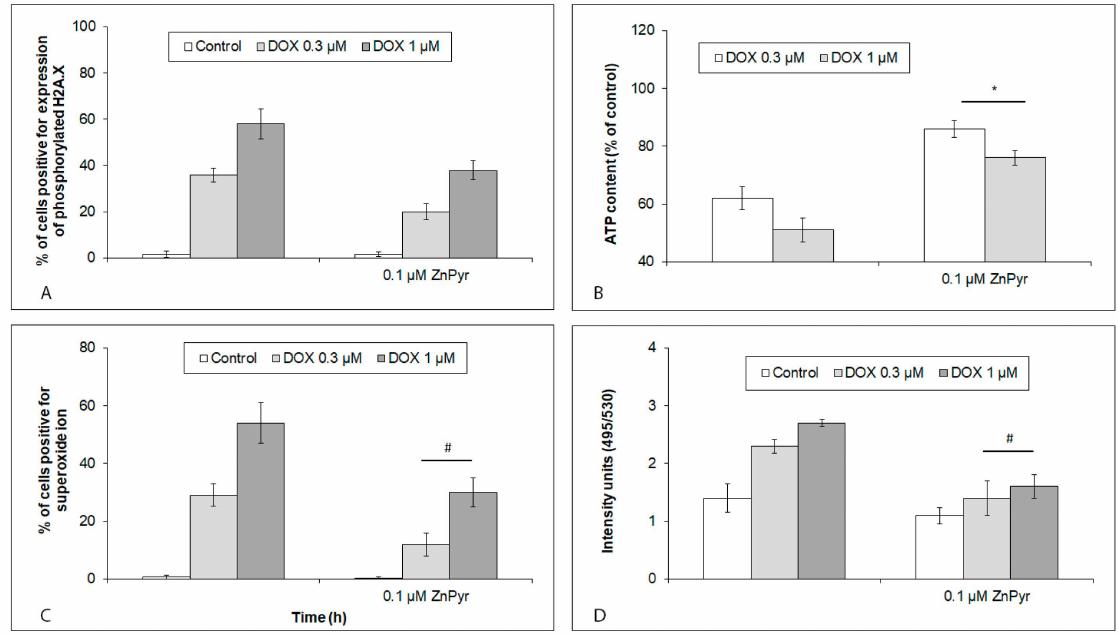
Figure 7. Effects of enhanced intracellular free Zn content on DNA damage, oxidative stress, and mitochondrial and lysosomal status in hiPCS-CMs exposed to 0.3 µ M and 1 µ M DOX at 120 h. Cardiomyocytes were treated with 0.1 µ M zinc pyrthione (ZnPyr) alone or together with 0.3 µ M and 1 µ M DOX concentrations, and ( A ) DNA damage, ( B ) mitochondrial production of ATP, ( C ) generation of superoxide ion, and ( D ) lysosomal membrane permeabilization were determined by particular assays and procedures, as described in Section 4. Values represent means ± SD of N = 3 (DNA damage), N = 3 (ATP production), N = 3 (superoxide), and N = 3 (lysosomal permabilization) experiments. #, * p < 0.05 compared to untreated cells with enhanced free Zn content at the same treatment interval with one-way ANOVA test and Dunnett’s post test for multiple